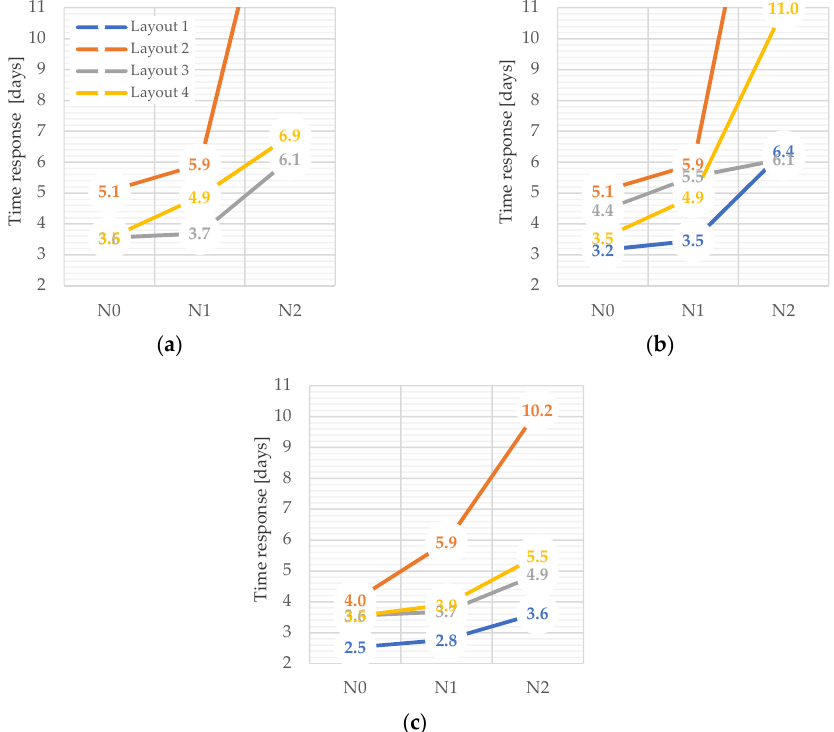
Figure 13. The response time of optimised monitoring strategies: ( a ) damage scenario D1; ( b ) damage scenario D2; ( c ) damage scenario D3.